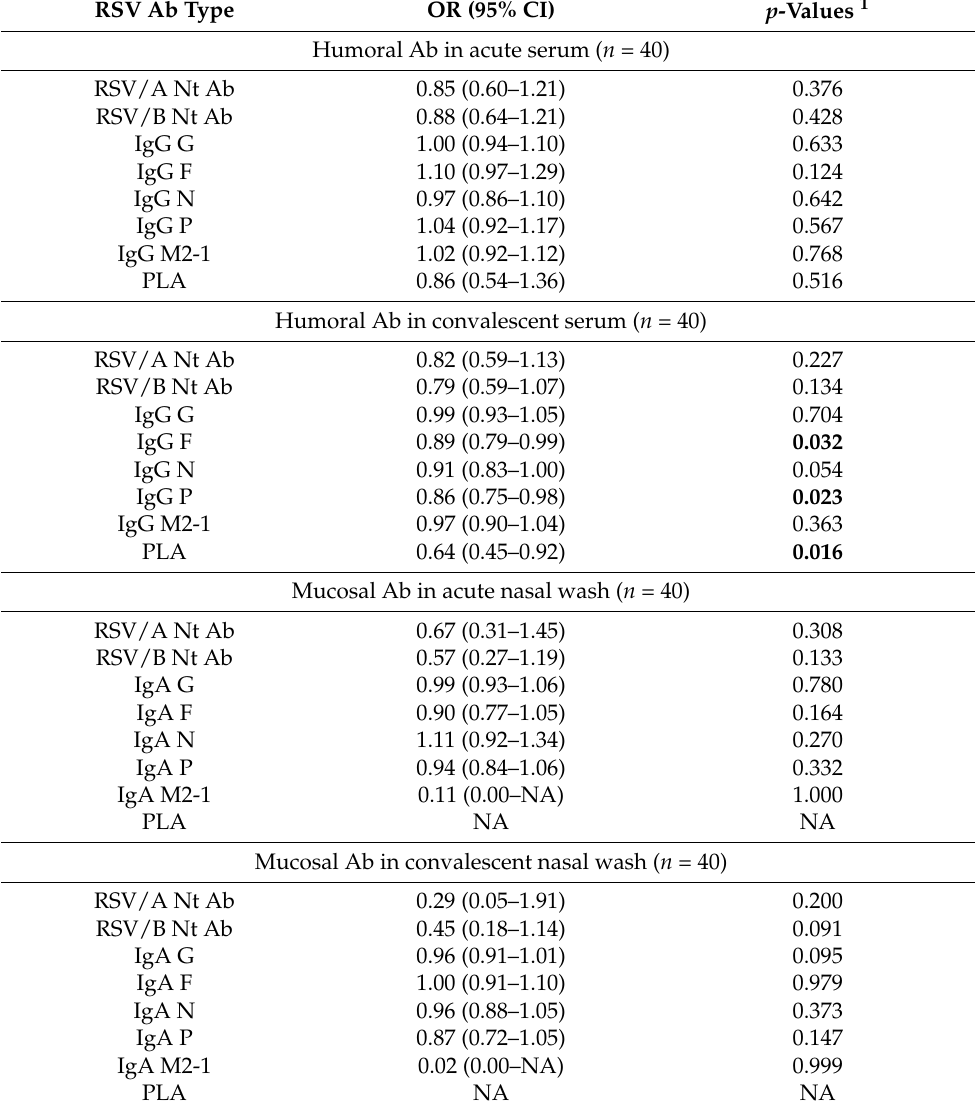
Table 3. Odds Ratios (ORs) for Association of Specific RSV Antibody with Virus Resolution in RSV-Infected HCT